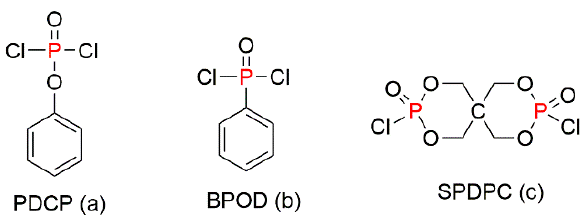
Figure 9. Chemical structures of phosphorous compounds used for the modification of g–C 3 N 4 [70,71].